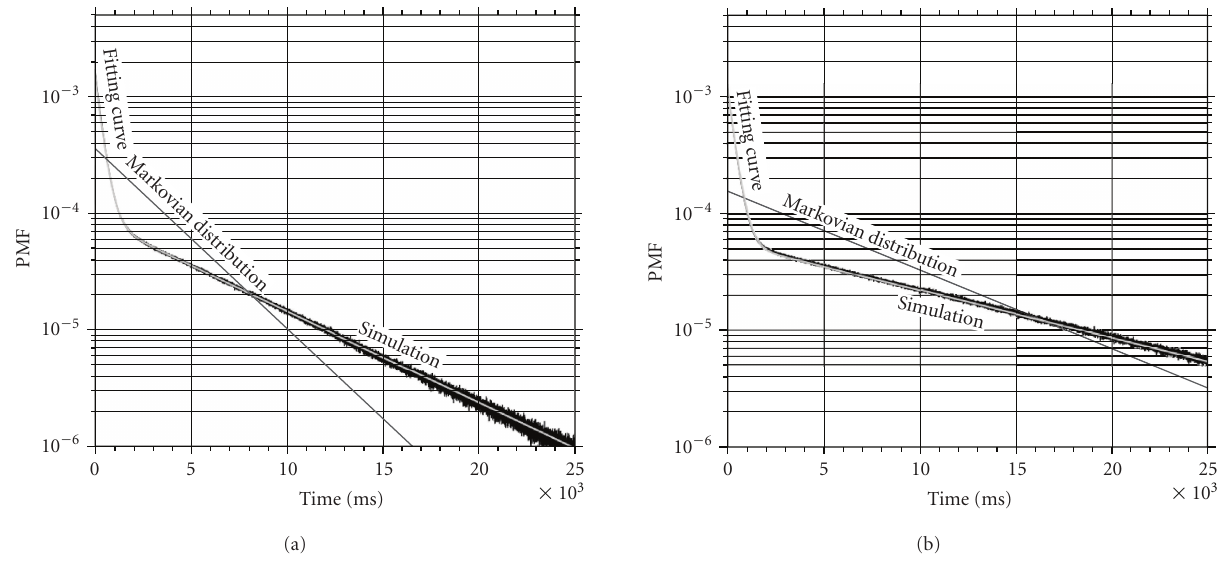
Figure 3: Probability mass function of the sojourn time in BB (a) and BG (b) macro-states in the urban environment (the PMF of a Markovian state with the same mean value is also shown; the white line represents the interpolation fitting curve of simulation results).